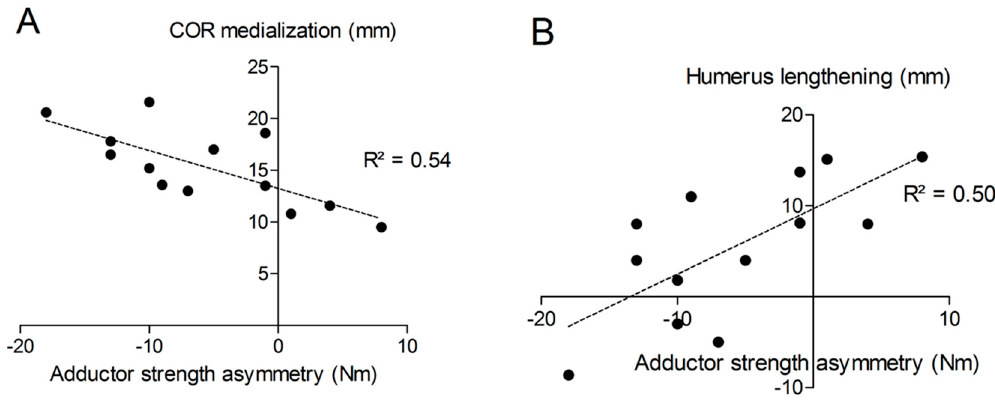
Figure 10. Correlations between shoulder adductor strength asymmetry and COR medialization ( A ) or humerus lengthening ( B ).